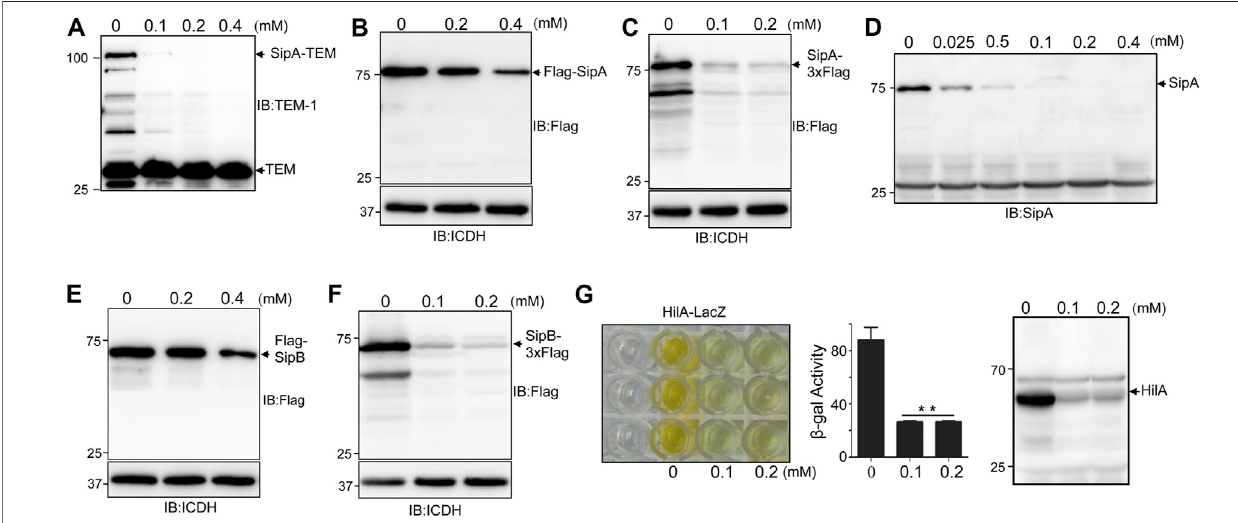
FIGURE 1 | Treatment by thymol reduced the protein level of several virulence factors associated with SPI-1. (A – D) Thymol affects the cellular level of SipA or its fusiontovarioustagsexpressedbydifferentpromoters.Culturesof S.typhimurium harboringtheconstructthatdirectstheexpressionofSipA – lactamase (A) ,Flag – SipA from a high-copy plasmid driven by the tac promoter (Luo and Farrand, 1999) (B) , SipA – 3xFlag from the chromosome (C) , or its endogenous form was treated with the indicated concentrations of thymol for 4 h. Cleared cell lysates resolved by SDS-PAGE were probed for the fusion or SipA by antibodies speci fi c for the tag or the protein itself. Irrelevant proteins recognized by the antibody (A,D) and the ICDH were probed and served as loading controls (B,C) . (E – F) The induction of SipB degradation by thymol. Cultures of S. Typhimurium harboring a high-copy plasmid expressing Flag – SipB (A) or SipB – 3xFlag on the chromosome were incubated with the indicated concentrations of thymol for 4 h prior to cell lysis and immunoblotting with the Flag-speci fi c antibody. The metabolic enzyme ICDH was probed as loading control. (G) ThymolaffectsthestabilityofHilA.Culturesofan S .TyphimuriumstrainexpressingaHilA – LacZfusionfromthechromosomepreparedbyincludingthymolat the indicated concentrations were measured for β -galactosidase activity. The reduction in the yellow color product generated by β -galactosidase – induced ONPG hydrolysis (left) or the enzymatic activity in miller unit (middle panel) was shown. Lysates of wild-type bacteria treated with thymol were probed by immunoblotting with a HilA-speci fi c antibody (right panel). The experiments were repeated at least three times each with independent biological samples; bar, s.e.m. ( n (cid:2) 3); **, p < 0.01.